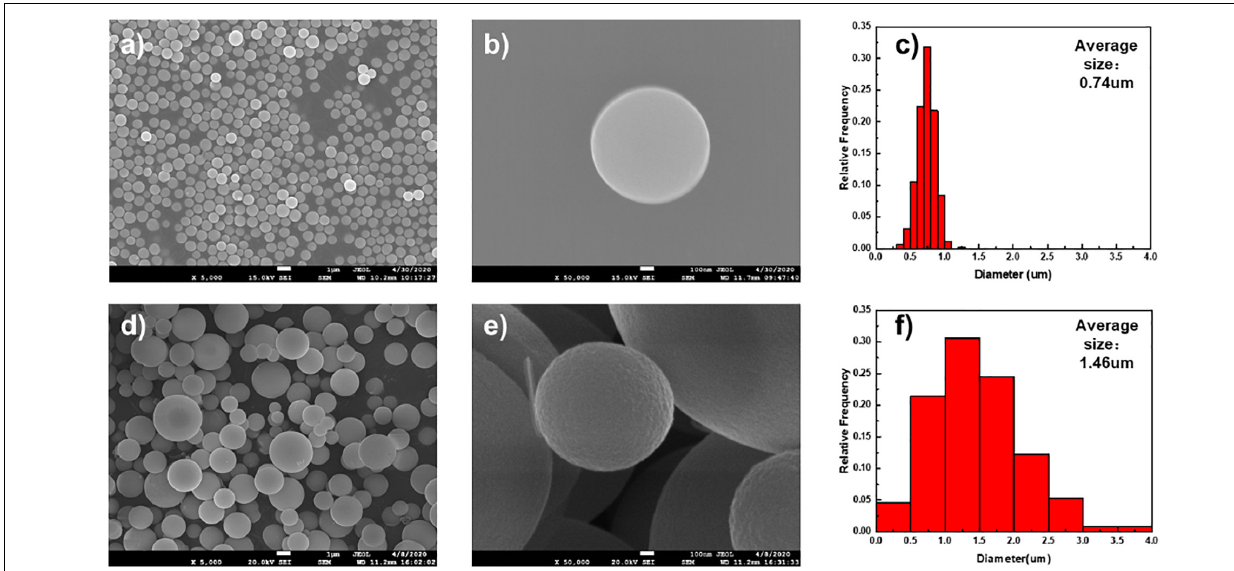
FIGURE 1 | SEM images and diameter statistics of (a–c) MMOs and (d–f) CMOs.